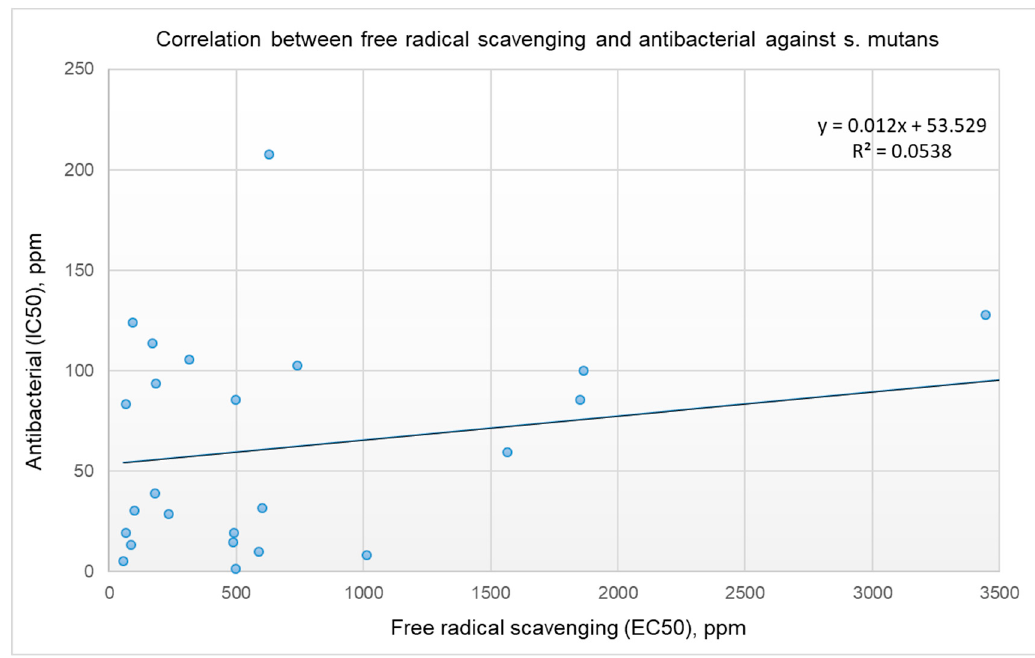
Figure 1. Correlations between the EC 50 for free radical scavenging and antibacterial activity (IC 50 ) for the non-polar extracts.